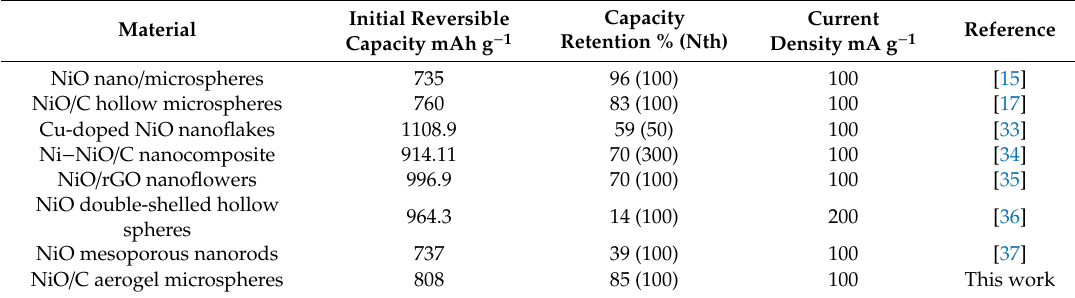
Table 1. Comparison in electrochemical performance between some published NiO-based anode materials and the NiO / C sample in the present